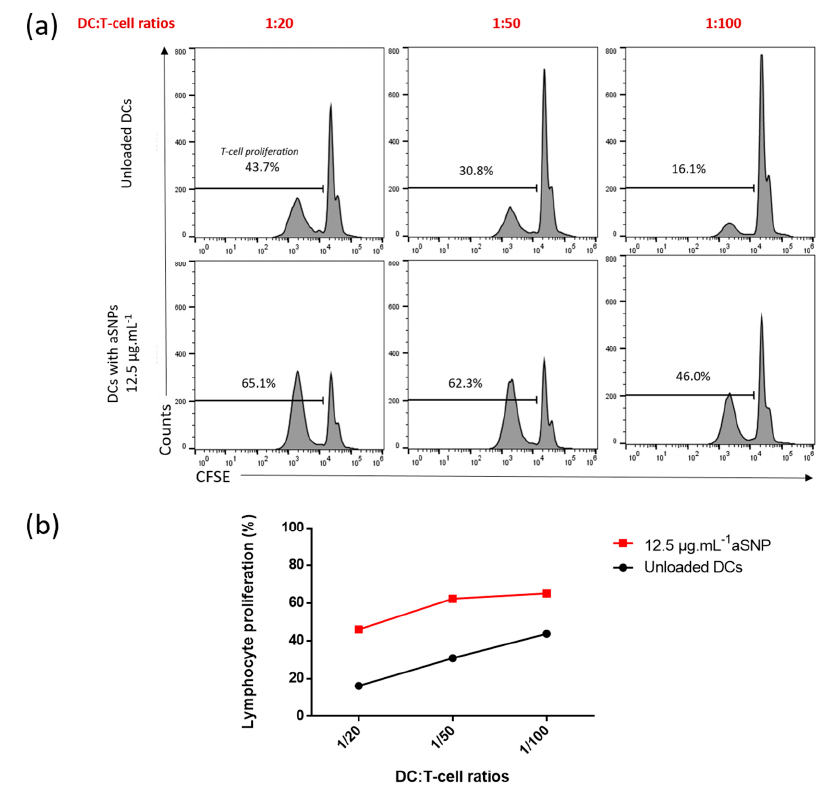
Figure 6. aSNP induced an increase in lymphocyte proliferation after 5 days of co-culture. Cells were incubated in the presence or absence of 12.5 µ g · mL − 1 of aSNP for 16 h. Treated MoDCs were co-cultured with allogeneic CD4 + T-cells labeled with CFSE at ratios of 1:20 (1 moDC for 20 CD4 + T-cells), 1:50 and 1:100). Proliferation was quantified after 5 days of co-culture as the percentage of CFSE low CD4 + T-cells. Untreated DCs were used as negative control. Results are shown as percentage of lymphocyte proliferation using FACS histogram ( a ) or curve ( b ) for a representative experiment.